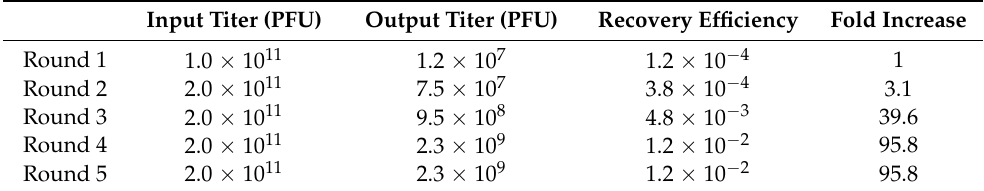
Table 1. Recovery efficiency after 5 rounds of biopanning. The recovery efficiency of each round was counted as the output divided by the input titer [21]. PFU, phage forming units.